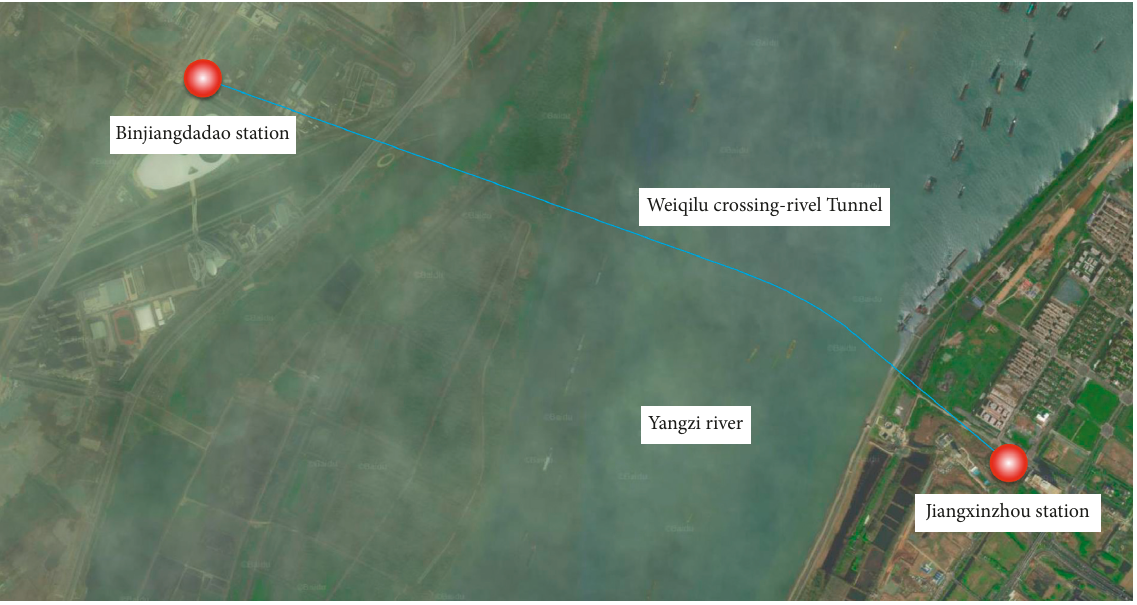
Figure 12: Plan of D10-TA03 bid section.